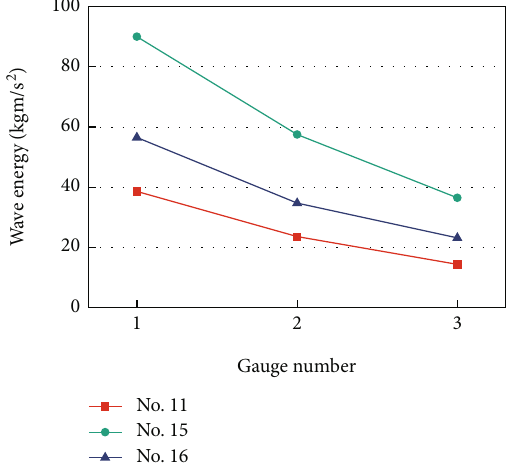
Figure 9: Wave energy of di ff erent shapes for the landslide body measured by di ff erent wave height